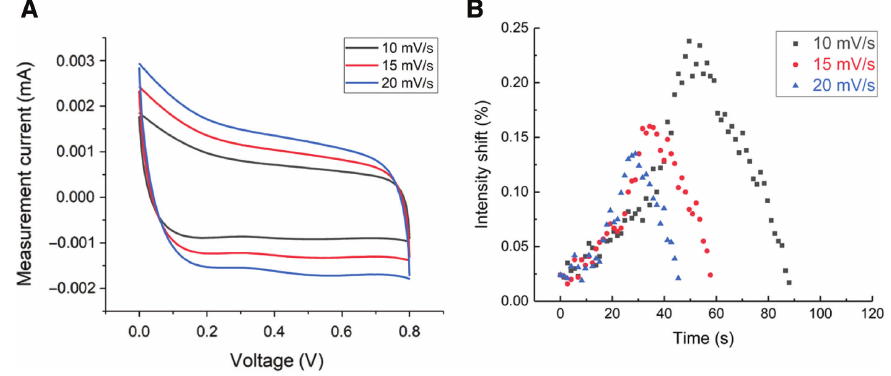
Figure 5: Charge and discharge tests in CV mode. (A) CV curves for MnO electrode at different scan rates. (B) Real-time intensity shift of fiber-optic LSPR sensors at different scan rates in CV 2 test (10 mV/S, 15 mV/S, 20